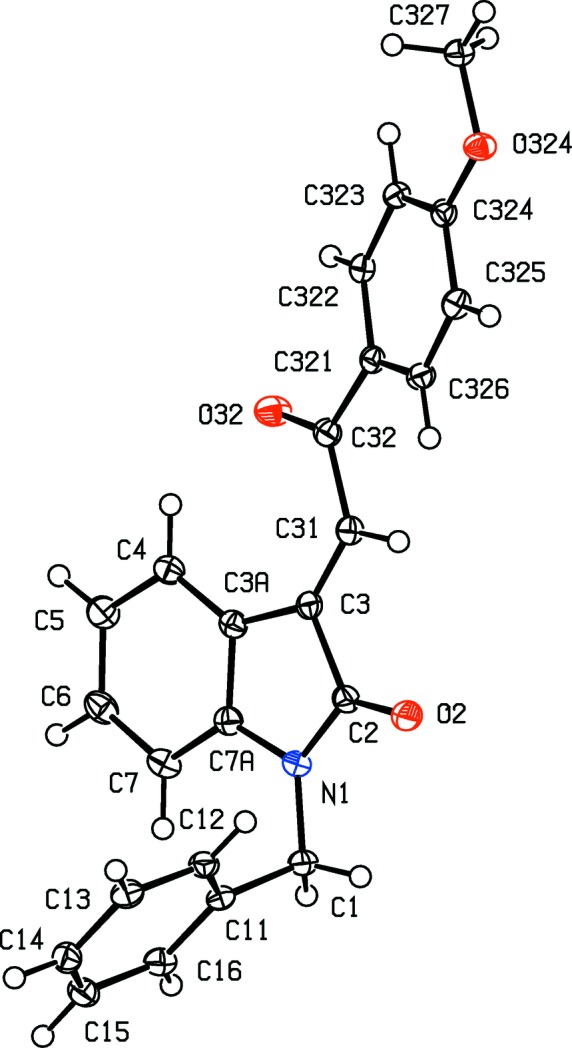
The mol­ecular structure of com­pound (IIc), showing the atom-labelling scheme. Displacement ellipsoids are drawn at the 30% probability level.